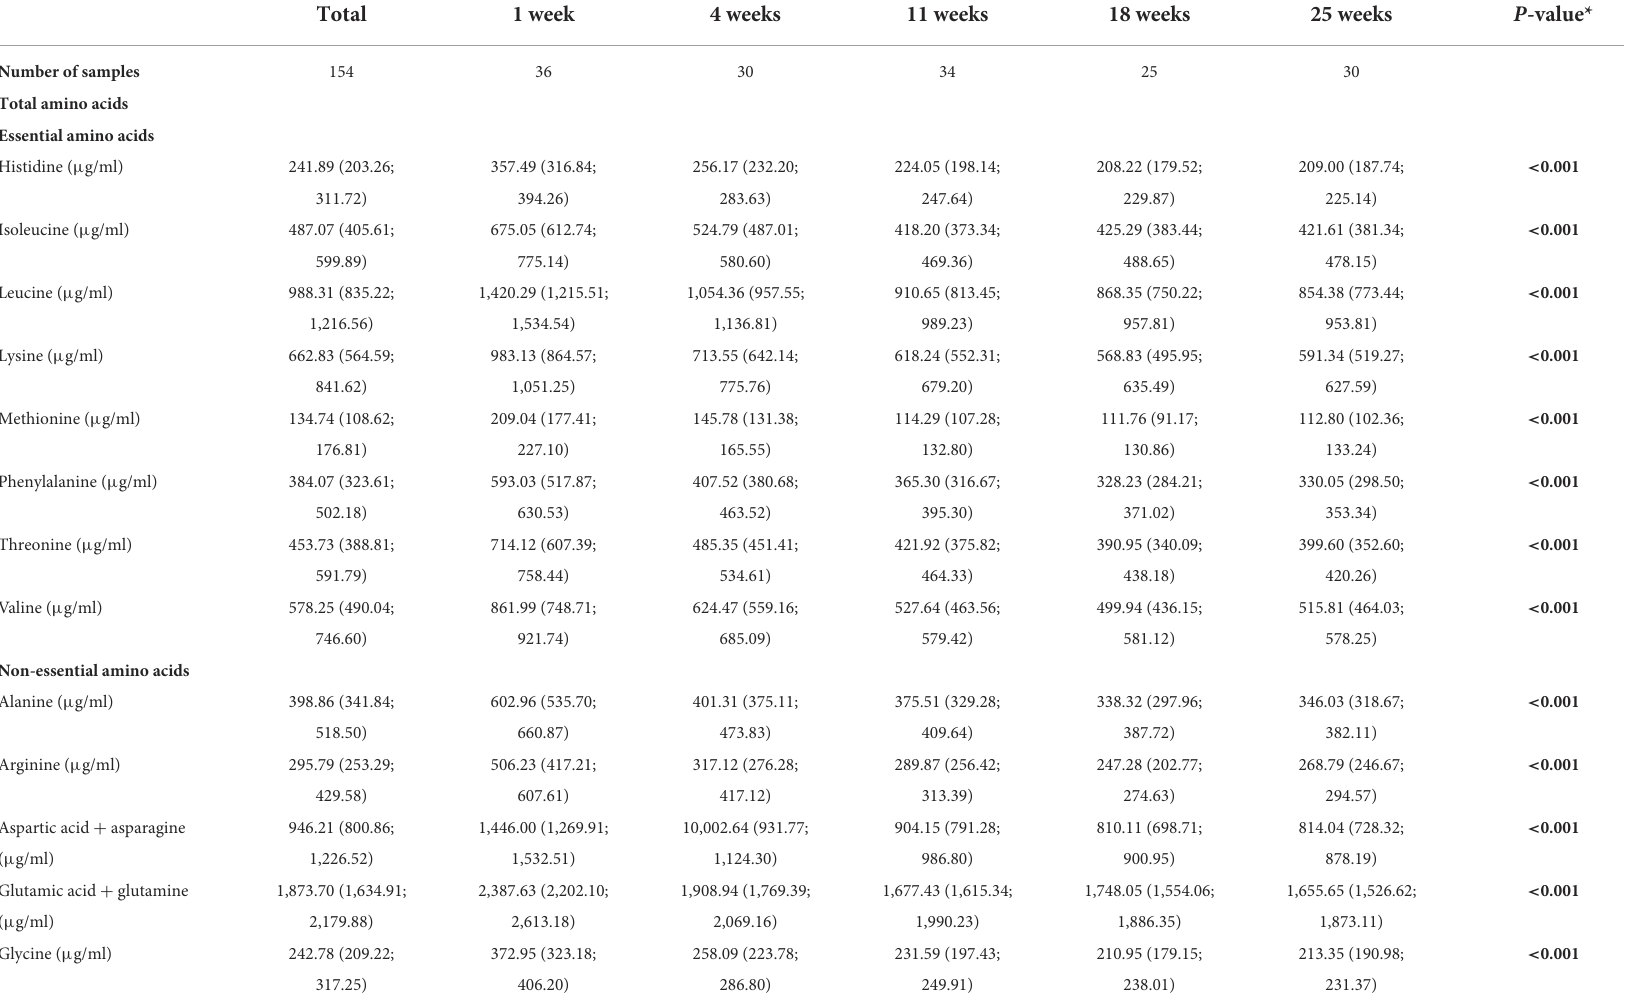
TABLE 4 Amino acids in human milk during